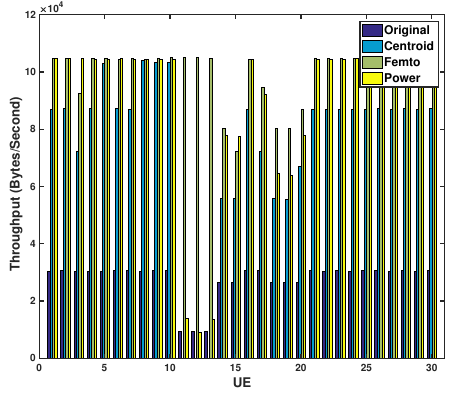
Figure 11. TBS vs. Number UEs Figure 12. Throughput vs. Number UEs